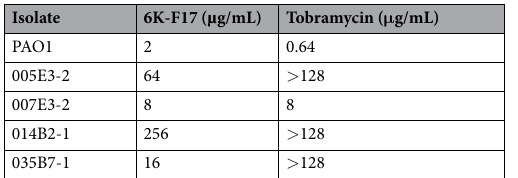
Table 1. Minimum inhibitory concentration of 6K-F17 and tobramycin against P . aeruginosa isolates a . a Experimental procedures are as previously described for MICs for 6K-F17 against lab strain PAO1 30,31 . See Methods section for